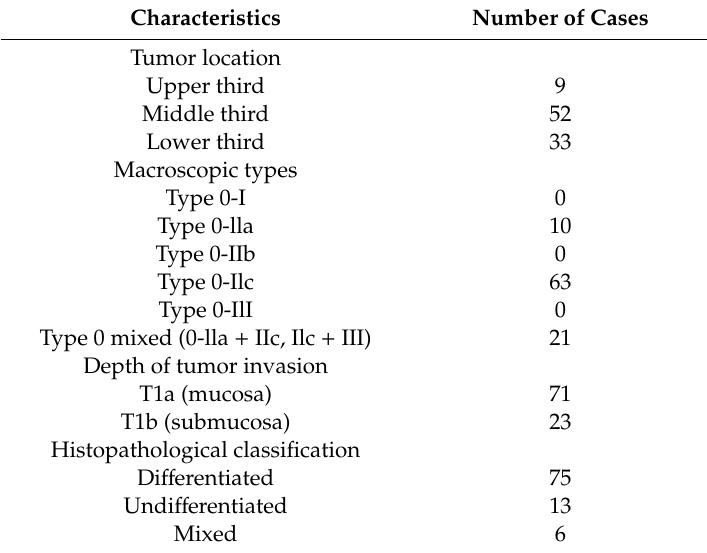
Table 1. Characteristics of patients and lesions in the gastric cancer test image set according to the Japanese classification of gastric